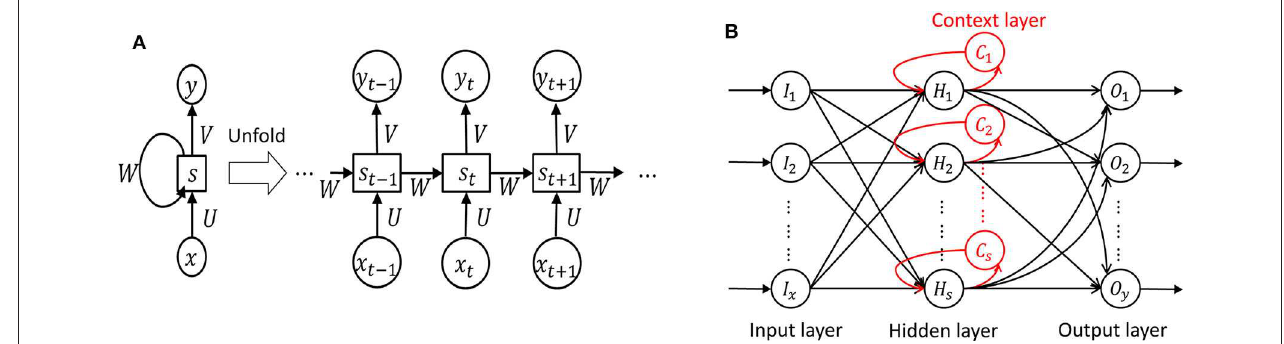
FIGURE 7 | Recurrent neural network (124). (A) Unfolded basic. (B) Elman